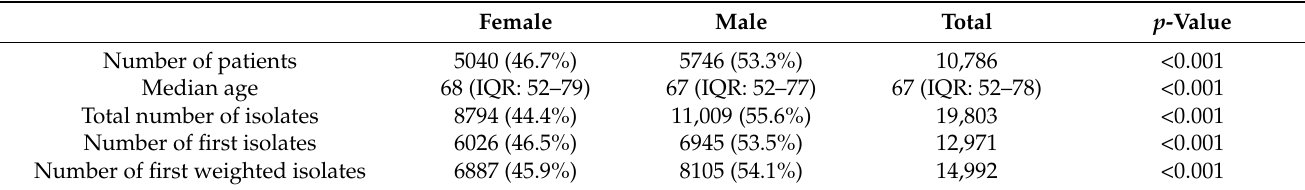
Table 1. Numbers and characteristics per gender of included patients of the included CoNS isolates.